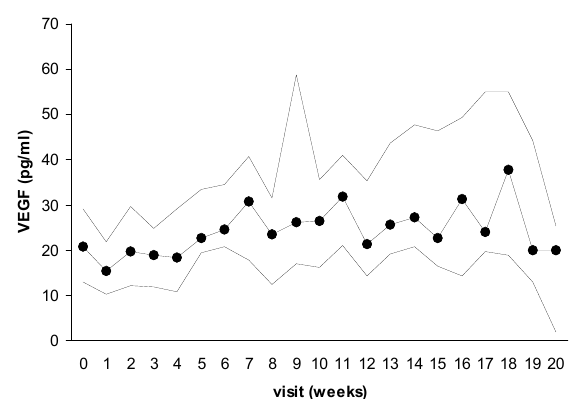
Figure 1. Plasma VEGF during dose-dense chemotherapy. Shown are the medians of plasma VEGF concentrations obtained in weekly intervals during the chemotherapy with 95 % confidence inter- vals indicated by the dashed line. Compared to base- line (visit 0) plasma VEGF was significantly (p < 0.05) decreased at visit (week) 1 and increased at visit 16.